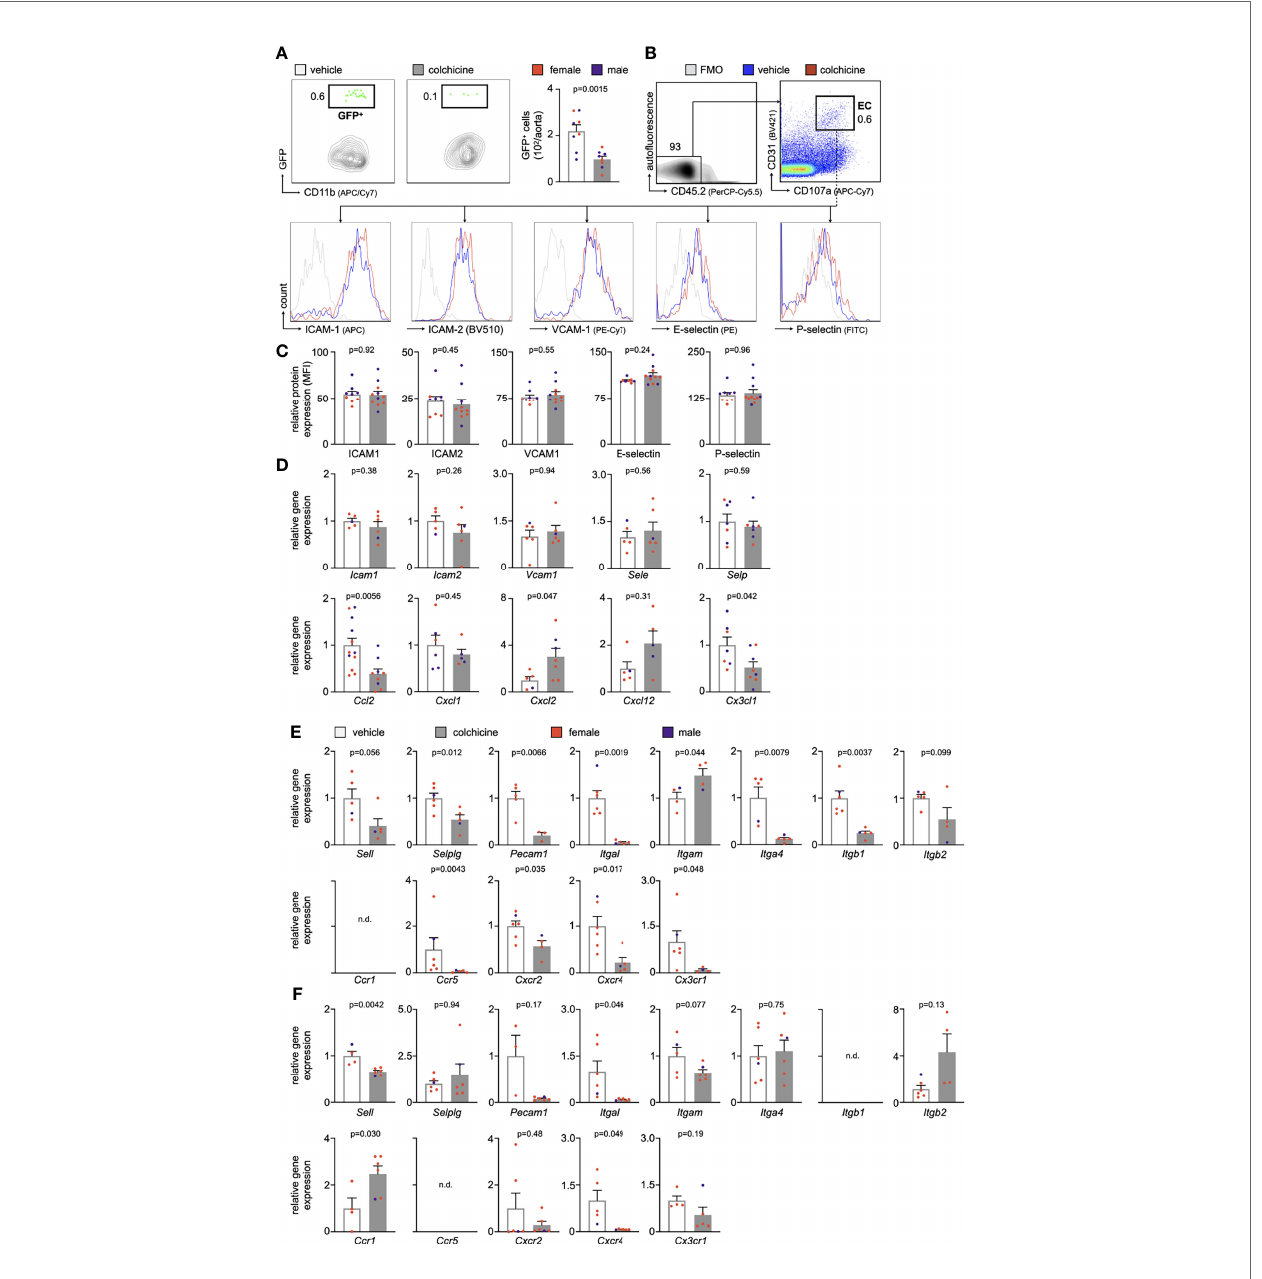
FIGURE 2 | Colchicine treatment dampens leukocyte recruitment to atherosclerotic aortas by silencing neutrophil and monocyte activation. (A) Flow cytometric gating and quanti fi cation of GFP high (GFP + ) myeloid cells in atherosclerotic aortas 24h after adoptive transfer of GFP high monocytes and neutrophils into vehicle- vs. colchicine-treated Apoe -/- mice ( n =8 per group, 38-50% female, Student ’ s t- test). (B) Gating strategy and histograms of leukocyte adhesion molecules on aortic endothelial cells (EC) from vehicle- vs. colchicine-treated Apoe -/- mice. (C) Quanti fi cation of mean fl uorescent intensities (MFI, representing relative protein levels) of adhesion molecules expressed by aortic endothelial cells from vehicle- vs. colchicine-treated Apoe -/- mice ( n =9-11 per group, 44-55% female, Student ’ s t -test or Mann-Whitney U -test as appropriate). Bar graphs indicate relative change of MFI standardized to controls. FMO ( fl uorescence minus one (respective antibody omitted)) control. Quantitative real-time PCR for gene expression quanti fi cation in fl uorescence-activated cell sorting (FACS)-puri fi ed (D) aortic endothelial cells, (E) blood neutrophils and (F) blood Ly6C high monocytes of vehicle- vs. colchicine-treated Apoe -/- mice ( n =3-12 per group, 33-100% female, Student ’ s/Welch ’ s t -test or Mann-Whitney U -test as appropriate). ICAM-1/ Icam1 (intercellular adhesion molecule 1), ICAM-2/ Icam2 (intercellular adhesion molecule 2), VCAM-1/ Vcam1 (vascular cell adhesion protein 1), E-selectin/ Sele , P-selectin/ Selp , L-selectin/ Sell , selectin P ligand/ Selplg , platelet endothelial cell adhesion molecule-1/ Pecam1 , integrin subunit alpha L/ Itgal , integrin subunit alpha M/ Itgam , integrin subunit alpha 4/ Itga4 , integrin subunit beta 1/ Itgb1 , integrin subunit beta 2/ Itgb2 , C-C motif chemokine ligand 2/ Ccl2 , C-X-C motif chemokine ligands 1 + 2+12/ Cxcl1/Cxcl2/Cxcl12 , C-X3-C motif ligand 1/ Cx3cl1 , C-C chemokine receptor types 1 + 5/ Ccr1/Ccr5 , C-X-C Motif chemokine receptor types 2 + 4/ Cxcr2/Cxcr4 and C-X3-C Motif Chemokine Receptor 1/ Cx3cr1 . Data are presented as mean+s.e.m. Numbers next to gates indicate population frequencies (%). Dots within bar plots show the gender of the mice with a color code: purple (male) and red